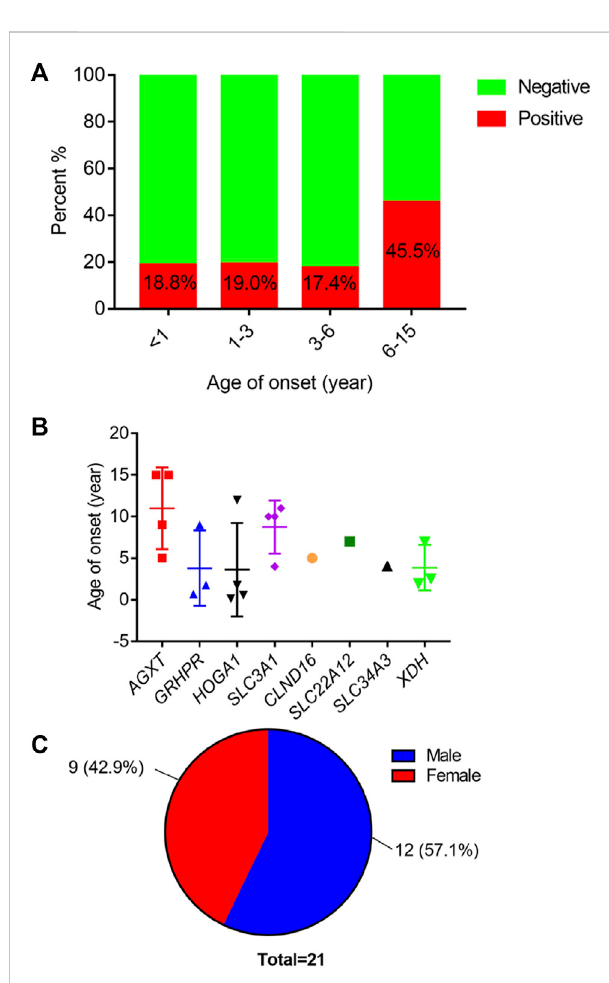
FIGURE 3 (A) Distribution of positive cases by age of onset. (B) Distribution ofageofonsetacross mutated causative genes. (C) Distribution ofthe number of positive individuals by